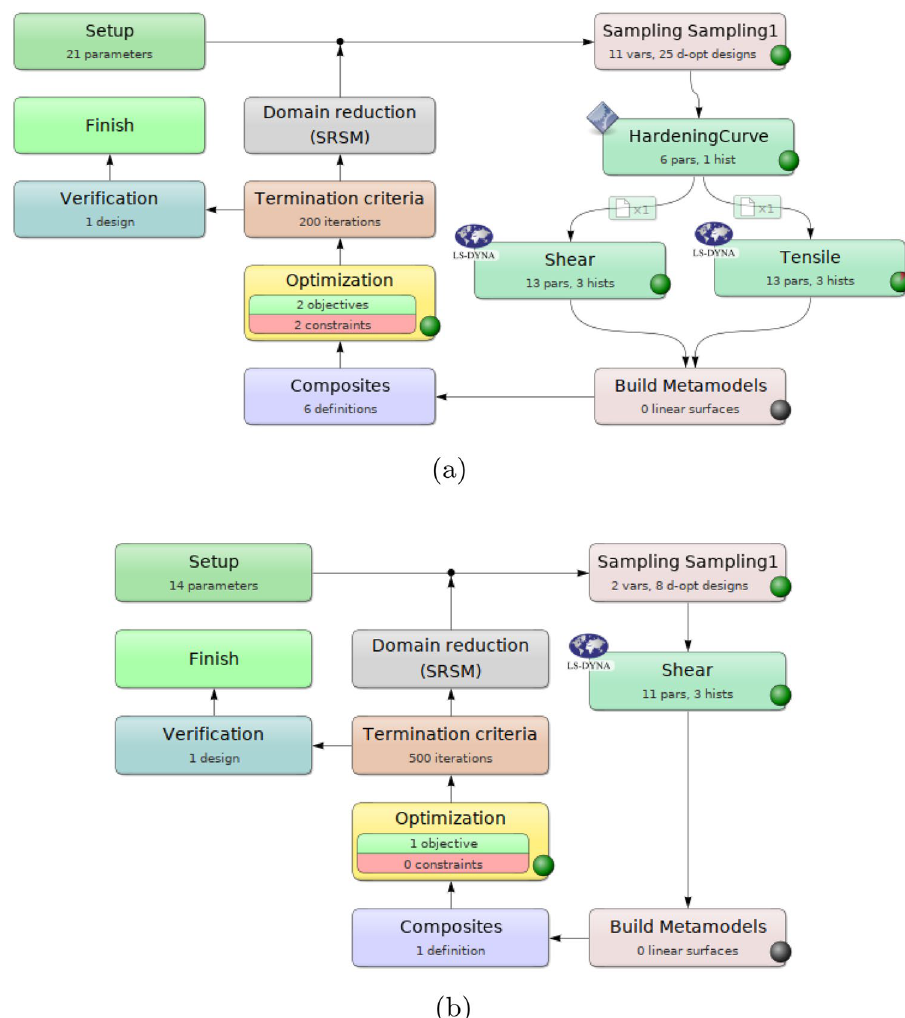
Fig. 8 In a , the flowchart used for determining the constituents of the anisotropic elastic- and yield tensors (Eq. (13) and (14)), as well as the the hardening curve, is presented. In b , the flowchart used for determining the parameters of the damage model is pre-